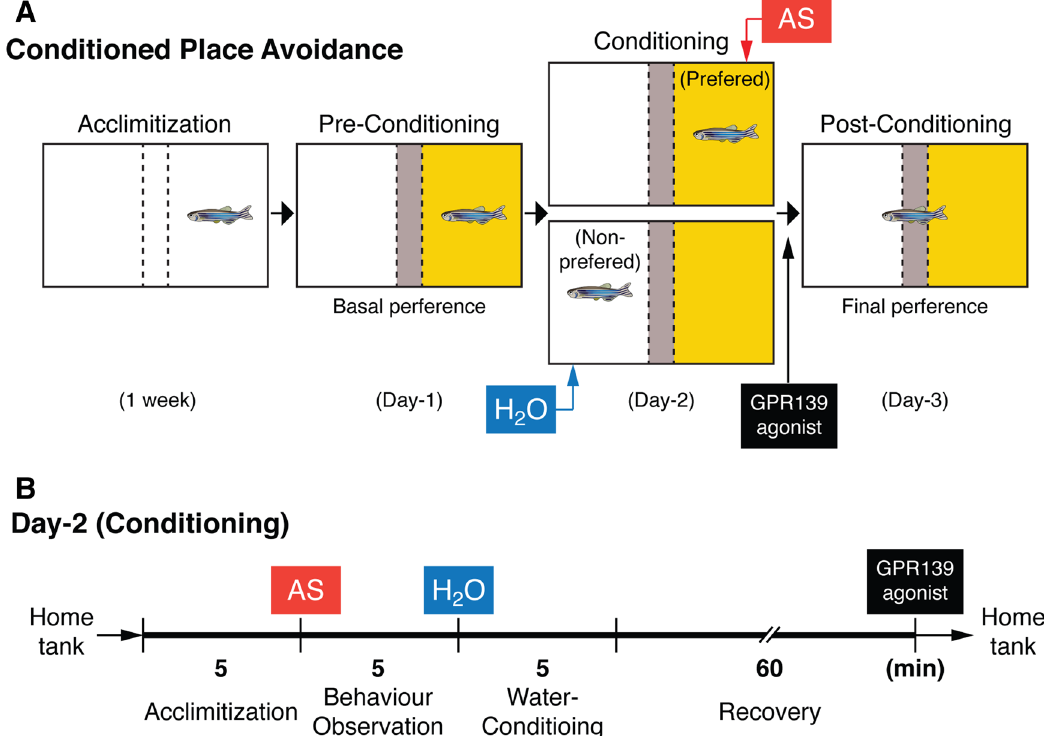
Figure 7. Alarm substance-induced fear conditioning and GPR139 agonist treatment timeline during the conditioning. ( A ) Schematic drawing of conspecific alarm substance (AS)-induced fear conditioning paradigm. Adopted by Sivalingam et al. (2020) 30 . During pre-conditioning (Day-1), fish was given a choice for their preferred colour, either yellow or white coloured compartment (basal preference). After conditioning to AS-induced fear responses (Day-2), their change in preference was assessed based on their total time spent in AS-paired (originally preferred) compartment as compared to the initial preference (Day-3). ( B ) On Day-2 (conditioning phase), fish were individually placed into the compartment, and after 5 min of acclimatisation time, AS was delivered in water followed by 5-min of video recording. The fish was then immediately transferred into the non-preferred compartment of the new experimental tank and exposed with 2 mL of distilled water (H 2 O) for 5-min. In order to avoid the conditioning to AS-induced fear but not to intraperitoneal- administration and handling stress, GPR139 agonist was then intraperitoneally injected after 60 min of the recovery from the conditioned stimuli (in total 65-min from the fear conditioning), and fish were transferred to their respective home Fish (n = 10 per group) were intraperitoneally administered with three doses (0.1, 1, and 10 µg/g BW) of JNJ-63533054 or DW using a microinjector as described above, and individually transferred to a tank (361 mm L, 218 mm W), 256 mm H) for recovery from the anesthetisation. After the recovery (~ 10 min), the general locomotion (including distance travel and latency) of the fish were recorded for 10-min from the side-view. After 20 min of further acclimatisation, 1 mL of AS or DW was applied into the tank through a glass capillary positioned at the corner of the tank about 0.5 cm below the water level. The mean time for introduction through the capillary was 5 s. Immediately, after the exposure to AS/DW, following reference parameters of swimming behaviours of the fish (n = 10 per group) including the total distance swam, total freezing time (total absence of movement for 1 s or longer), total time spent, and the total swimming velocity that was only measured at the bottom of a tank as the fear responses occur mainly on the bottom of the tank upon AS delivery 57 . Effect of JNJ-63533054 on fear memory consolidation. Effect of JNJ-63533054 on fear memory consolidation was assessed using an AS-induced conditioned place avoidance paradigm that was previously established by Maximino and co-workers 32 with some modifications as described below (Fig. 7). AS‑paired conditioned place avoidance paradigm. Experimental apparatus. A test tank (31 cm L × 16 cm W × 20 cm H) divided into three-chambers using a lightweight board made of a corrugated plas- tic with yellow or white (13 cm L × 16 cm W × 20 cm H) and a grey central partition (31 cm L × 5 cm W × 20 cm H) and two sliding guillotine-type doors (16 cm × 20 cm) (Fig. 7A). The partition allows the water to move throughout the tank and the AS solution can be diffused throughout the tank in a minutes after application 58 . Another tank (31 cm L × 16 cm W × 20 cm H) used as an acclimatising tank, was similarly divided as above but by a transparent divider to allow conspecific to visualise in order to minimise isolation stress. The top view of